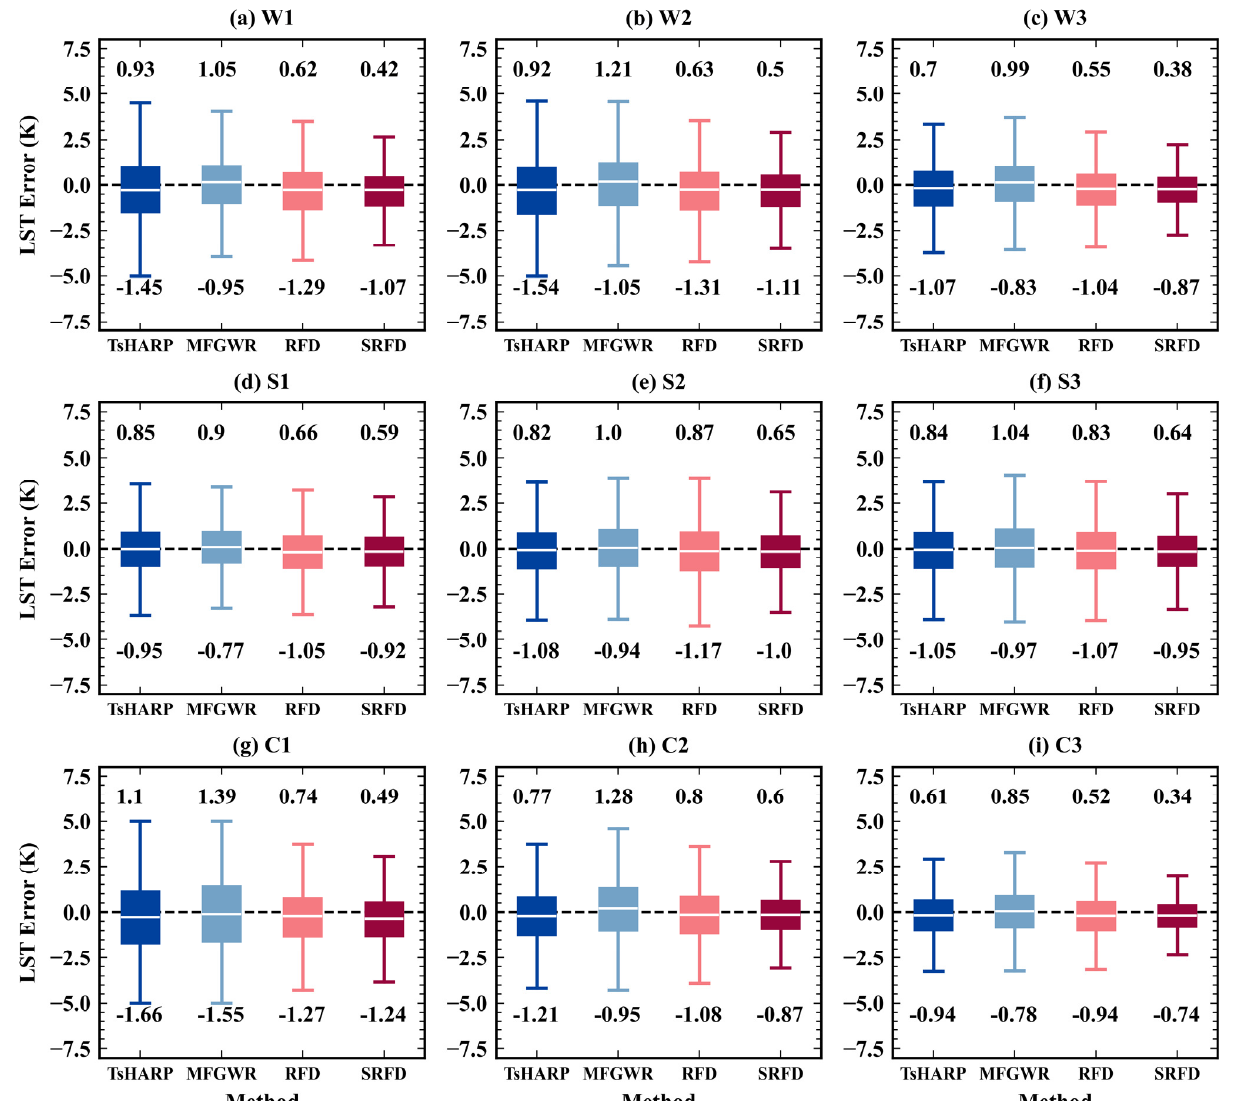
Figure 10. Error box plots of downscaling results of different methods. The marked values are upper and lower quartiles. The labels ( a – i ) represent the image IDs of W1, W2, W3, S1, S2, S3, C1, C2, and C3.